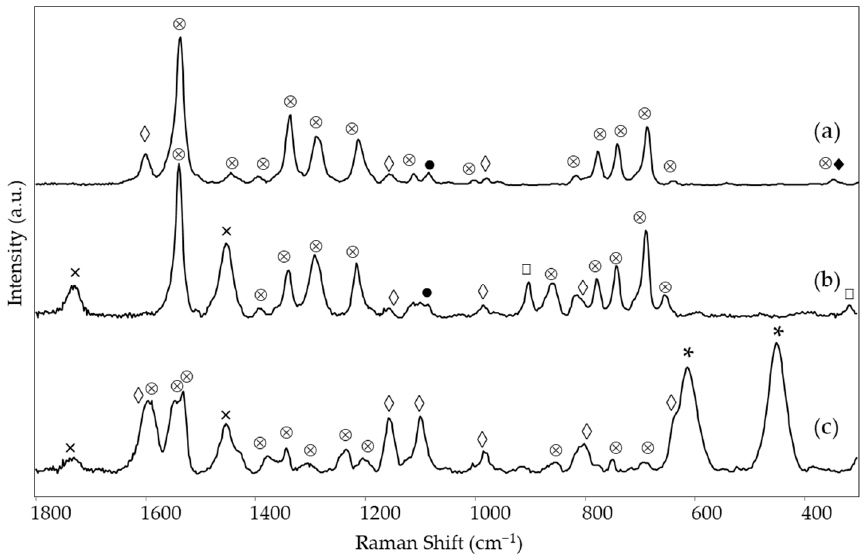
Figure 5. SSE™ Raman spectra of green areas: (a) The grammar of fire—Canto I , area 2, (b) The North star and the tree of life , area 4 and (c) Earthquake , area 3. Legend: ⊗ = pigment (for wavenumbers and assignments see Table 2), * = rutile, = CaCO 3 , = resin, (cid:0) = Sr 2 MgSi 2 O 7 , = ZnS, = binder (see text).